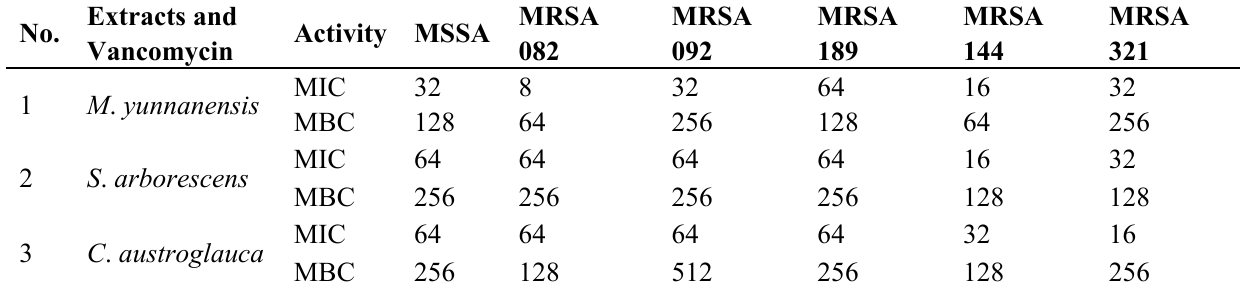
Table 5. Anti-MRSA activity of the extracts to the zone of inhibition against MSSA ≥ 10 mm (MIC/MBC: μ